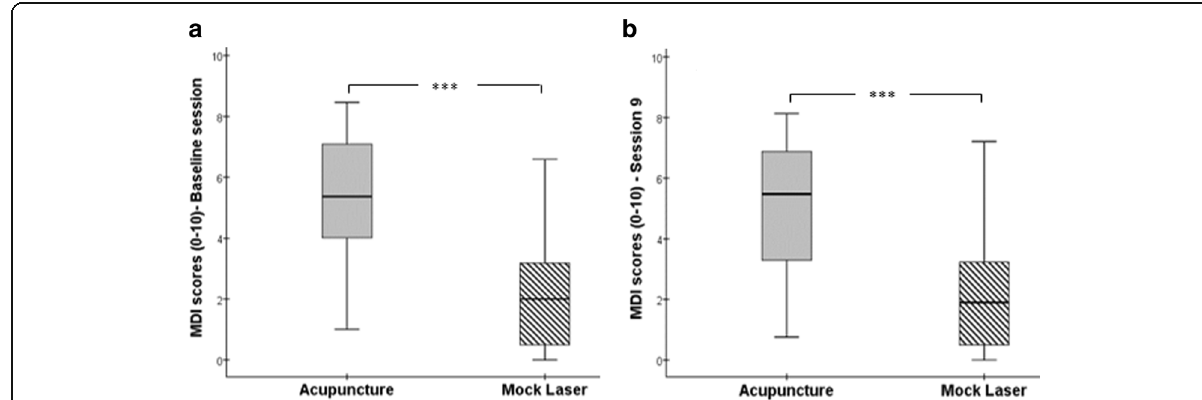
Fig. 3 a and b MASS De Qi Index (MDI) scores for the treatment and control group at session 1 and session 9 respectively, ( n = 47 for the treatment group, n = 37 for the control group). The boxes are bound by the interquartile range (IQR) (top of the box represents the 75th percentile, while the bottom of the box represents the 25th percentile). The boxes are divided by the median, and the whiskers attached to the box represent the minimum and maximum scores. ***: statistically significant difference ( p < 0.001) between the two